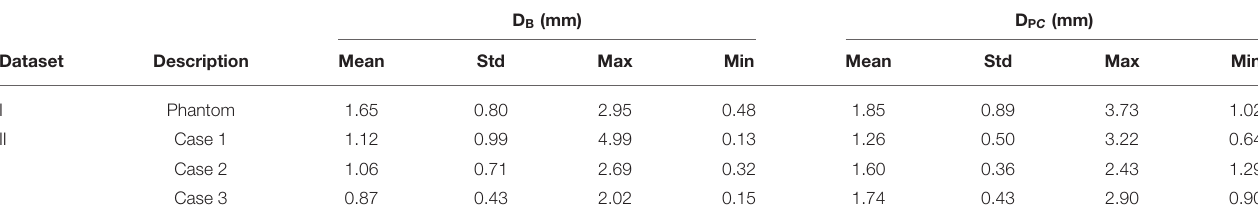
TABLE 3 | Summary of results obtained for Dataset I and II: mean, standard deviation, maximum, and minimum